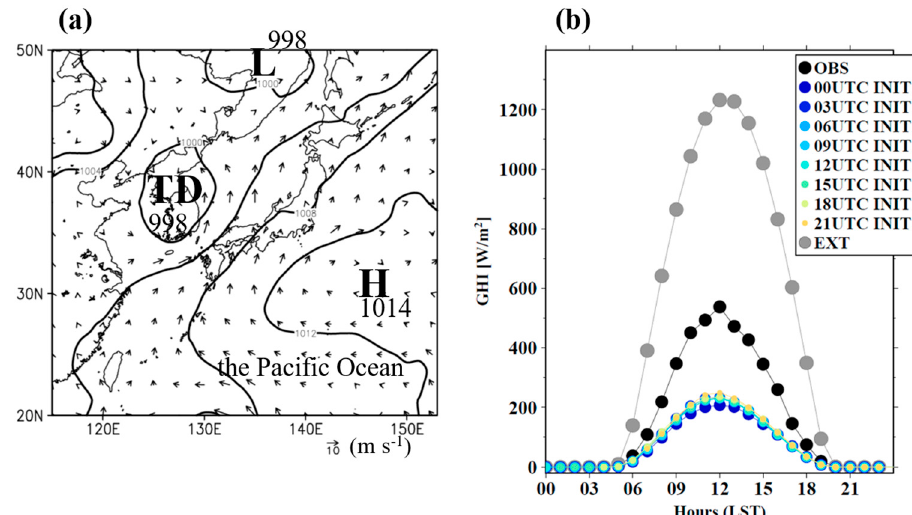
Figure 2. ( a ) Weather chart at 09 JST on 4 August 2014. ( b ) Time series of hourly GHI observations (black circles), meso-scale model (MSM) forecasts (colors), and extra-terrestrial solar irradiance on the same day for the integrated region of the nine electric power companies’ areas. Table 6. Daily mean bias error (MBE) and root mean square error (RMSE) values for each initialization time (from day-ahead forecasts to intraday-ahead forecasts) on 4 August 2014, and MBE and RMSE differences between the forecast with initialization time of 00 UTC and each of the other forecasts. Initial Time MBE RMSE (W m − 2